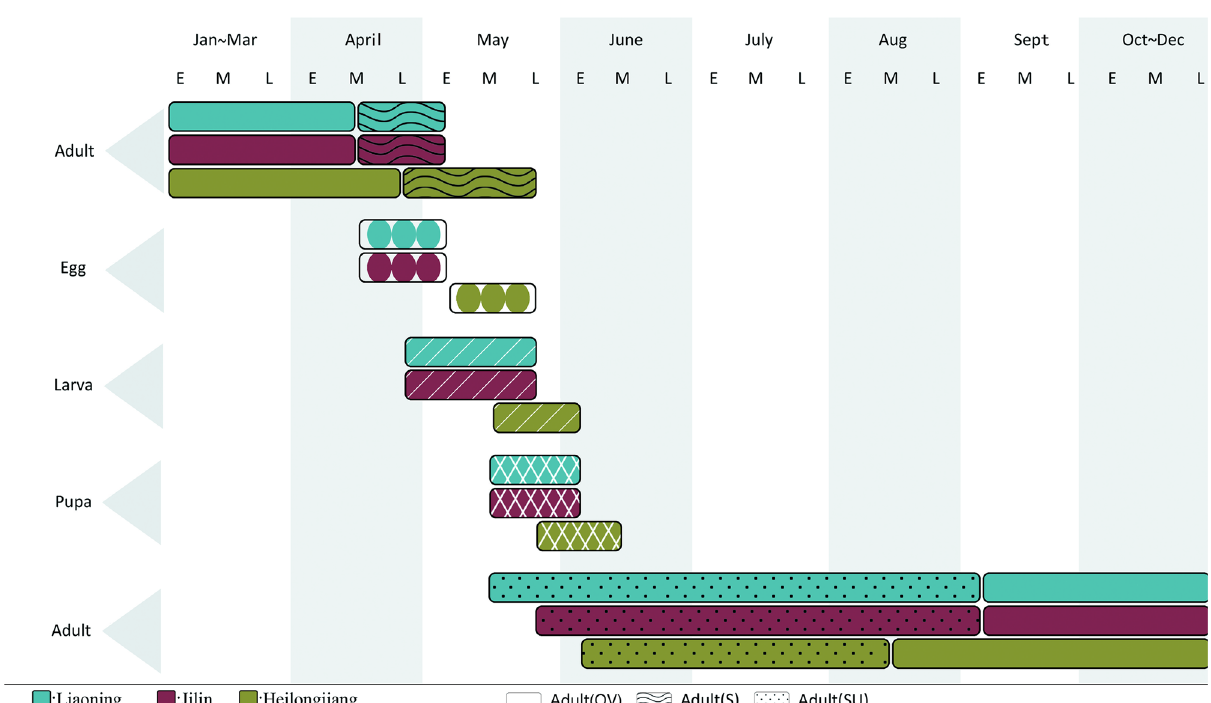
Figure 3. Life history of Rhynchaenus maculosus in Liaoning, Jilin and Heilongjiang provinces. Capital letters OV denote overwintering adult, S denotes spring adult and SU denote summer